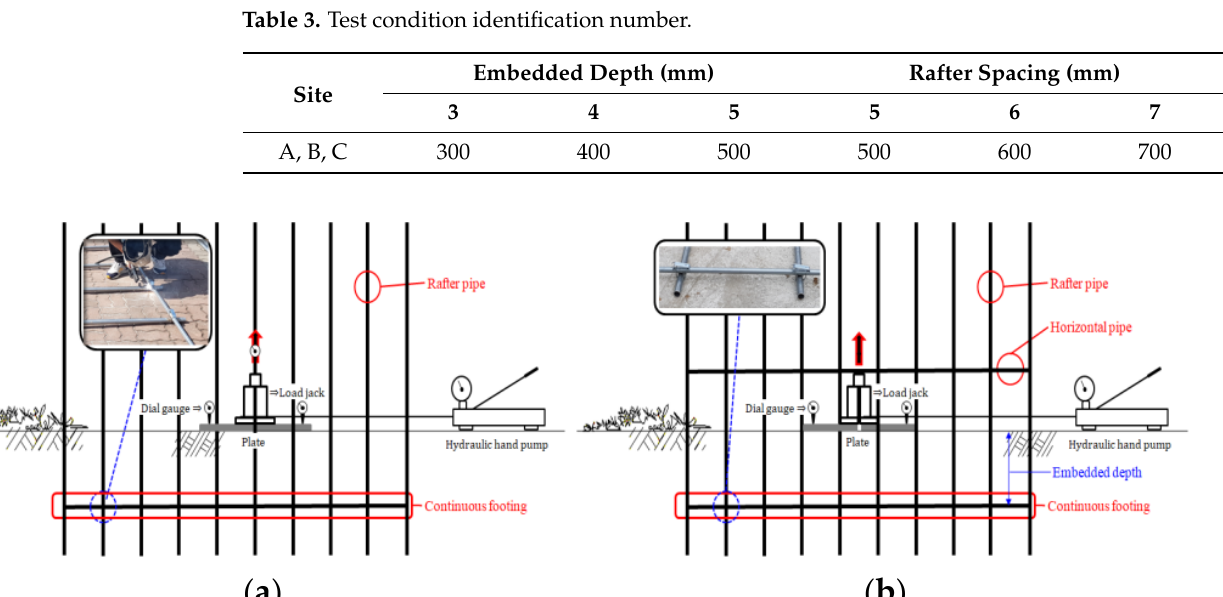
4 of 15 Figure 2. Construction materials for testing: ( a ) test pipe and pipe connector; ( b ) horizontal pipe connector; ( c ) vertical pipe connector. In the anti-disaster design standards of the Rural Development Administration, a to- tal of 19 types of single-span plastic greenhouses are classified. The specifications of the rafter and the purlin are the same, and the spacing of the rafter and the embedded depth of the continuous pipe foundation are presented in Table 2.